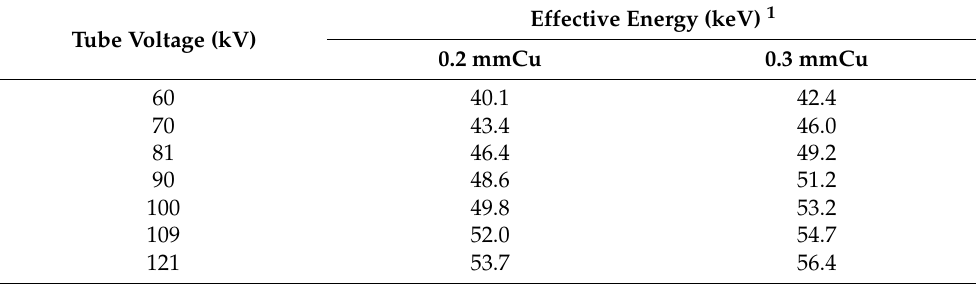
Table 1. Effective energy at different tube voltages and added filtration settings.